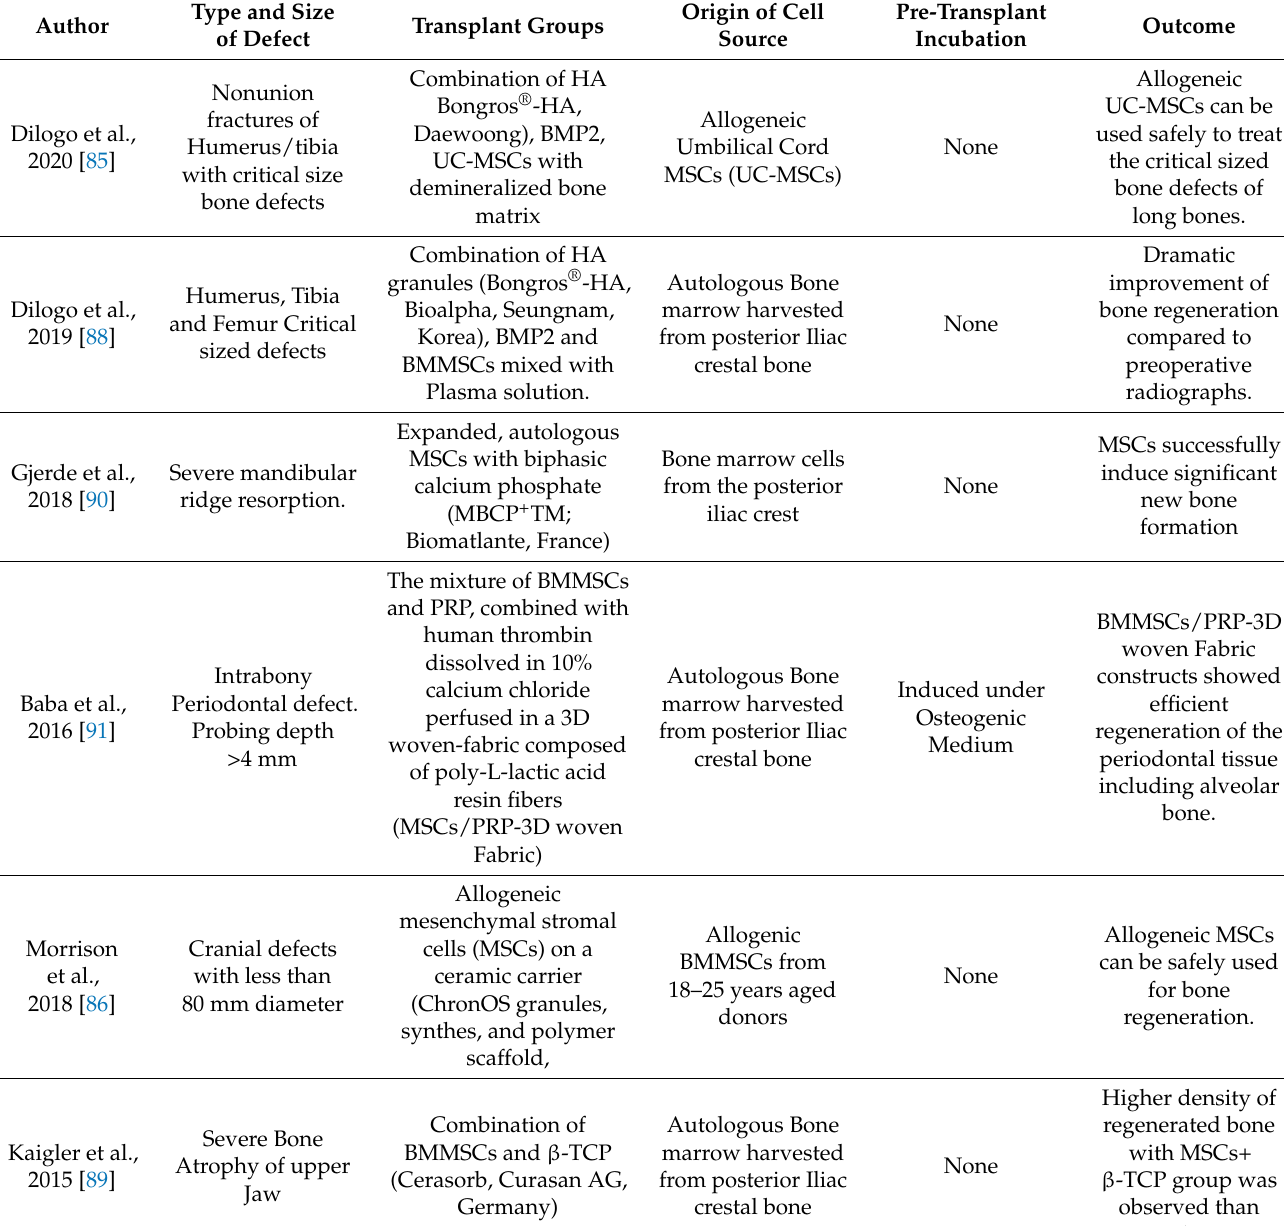
Table 2. Completed and published clinical studies using MSCs combined with biomaterials for bone tissue